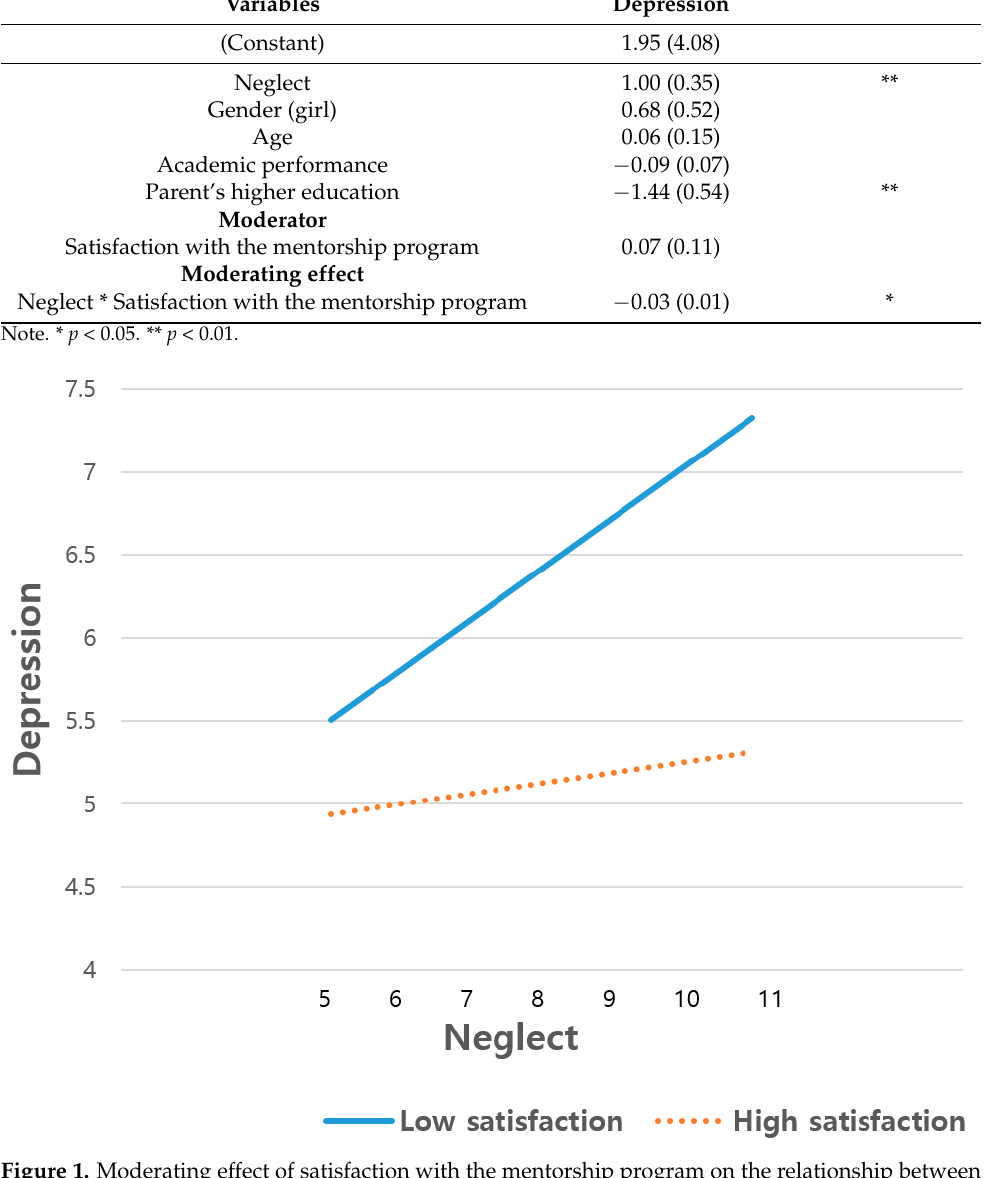
Figure 1. Moderating effect of satisfaction with the mentorship program on the relationship between neglect and depression among low-income students.